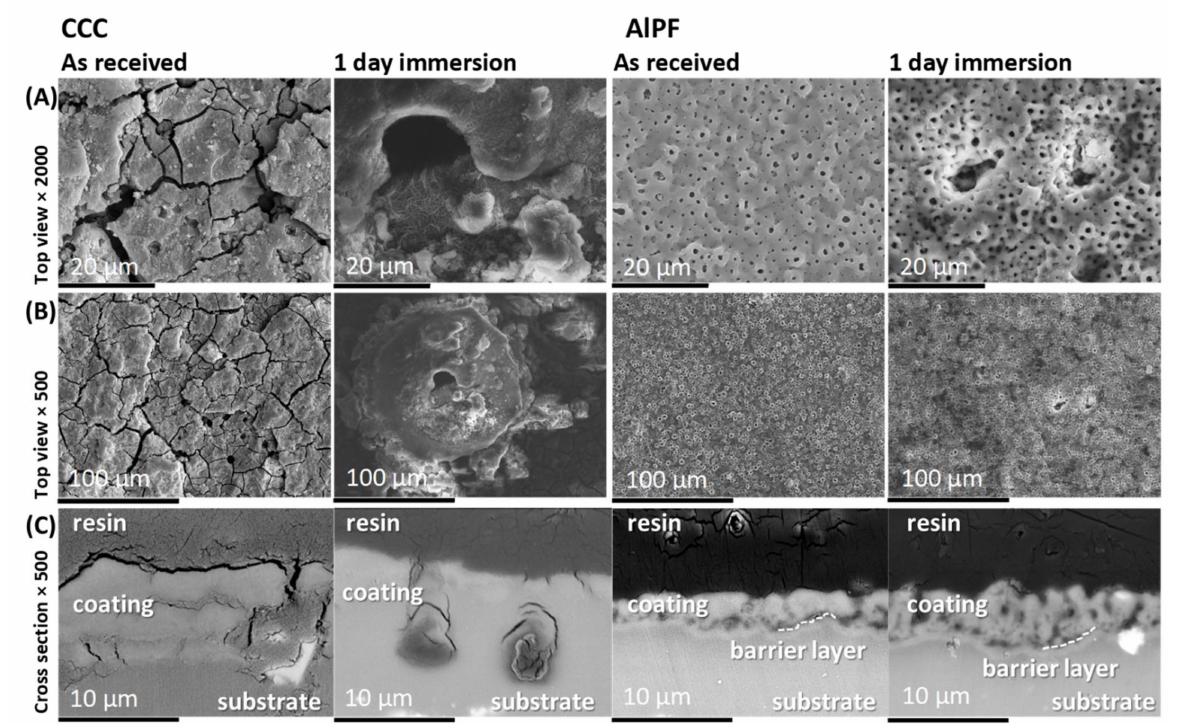
Figure 7. SEM microphotographs of top views (secondary electron images (SEI)) and cross-sections (BEI) of CCC and AlPF coatings before and after 1 day of immersion in 0.5% NaCl and EIS